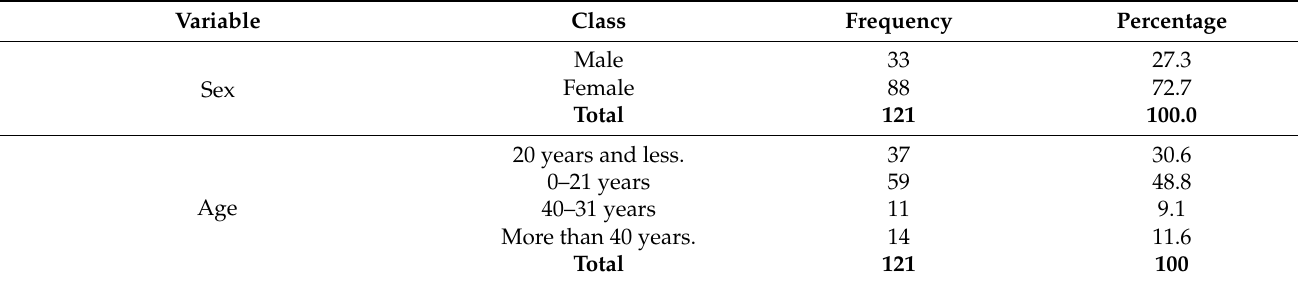
Table 1. The study sample members by demographic